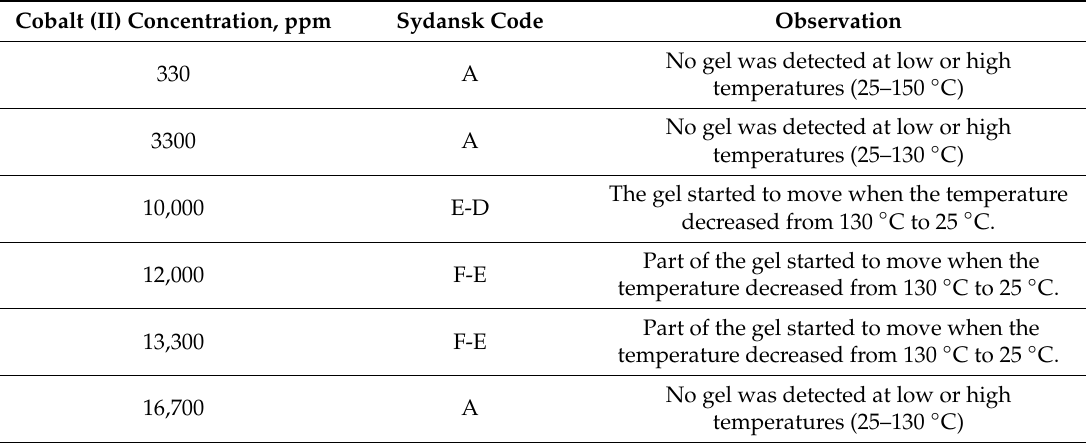
Table 2. Crosslinking of 9% PaM with CoAc at a pH of